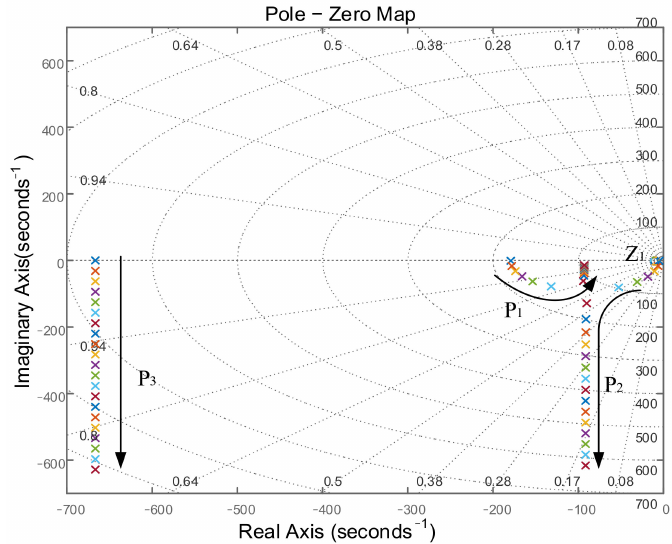
Figure 12. Zero pole distribution diagram of the accurate motor